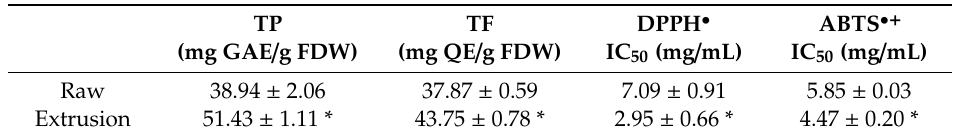
Table 4. Total phenolic content, total flavonoid content, and radical scavenging IC 50 values of freeze-dried water extract from optimal extruded mulberry